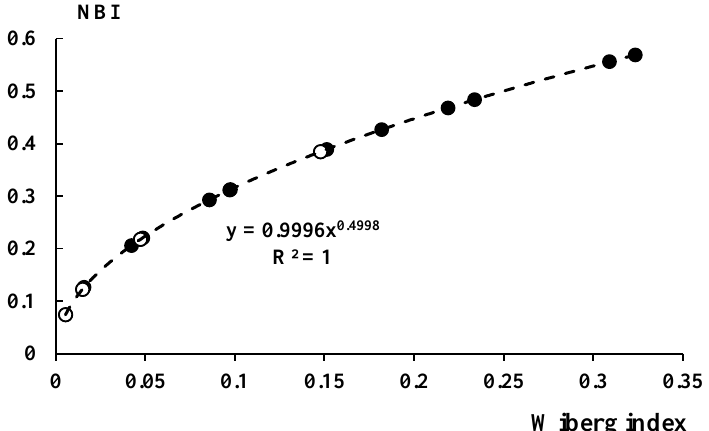
Figure 10. Correlation between NBI and Wiberg indices. Potential regression is applied; all dimers linked by halogen (black circles) and hydrogen (open circles) bonds are taken into account in this correlation.